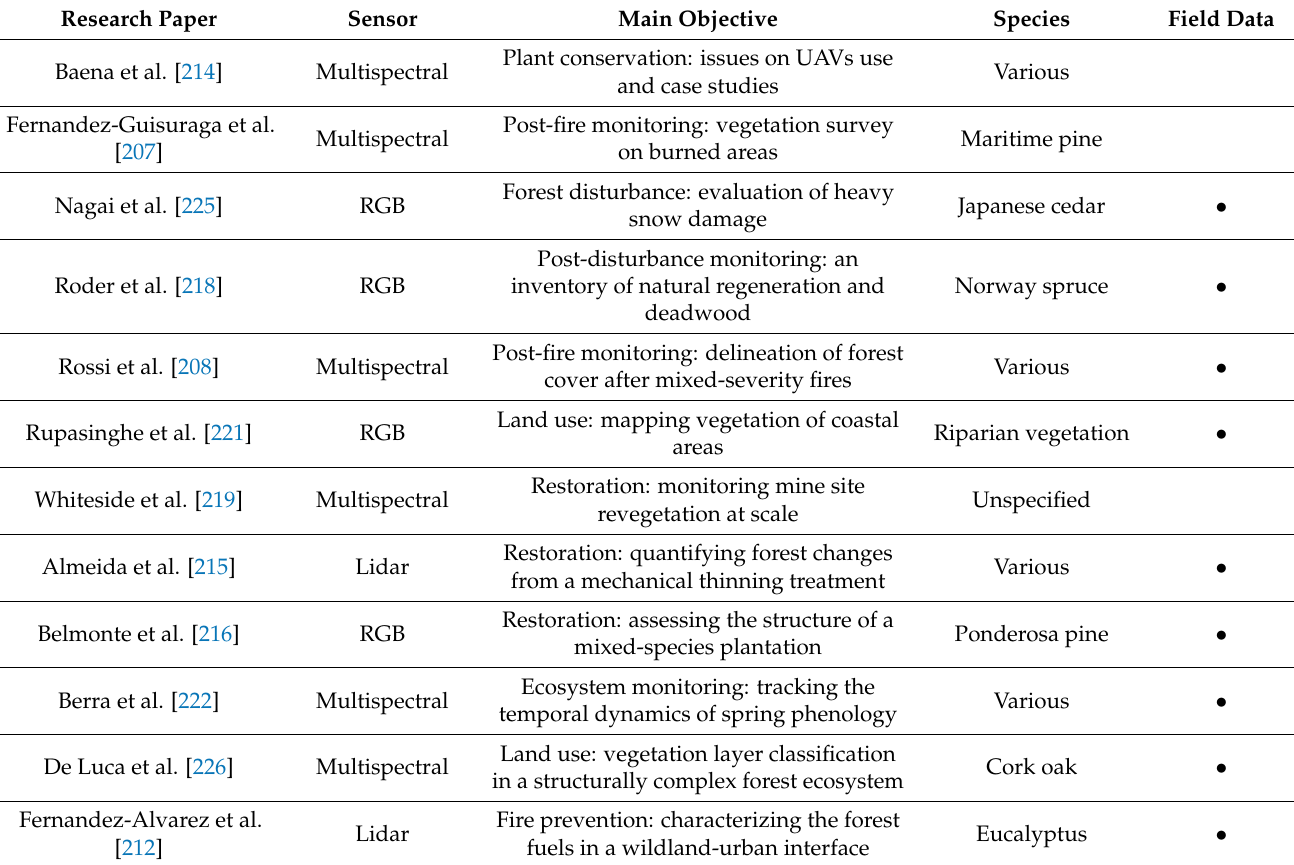
Table 6. Reviewed studies for conservation, restoration, and fire monitoring topic: sensor, main objective, species, and field data